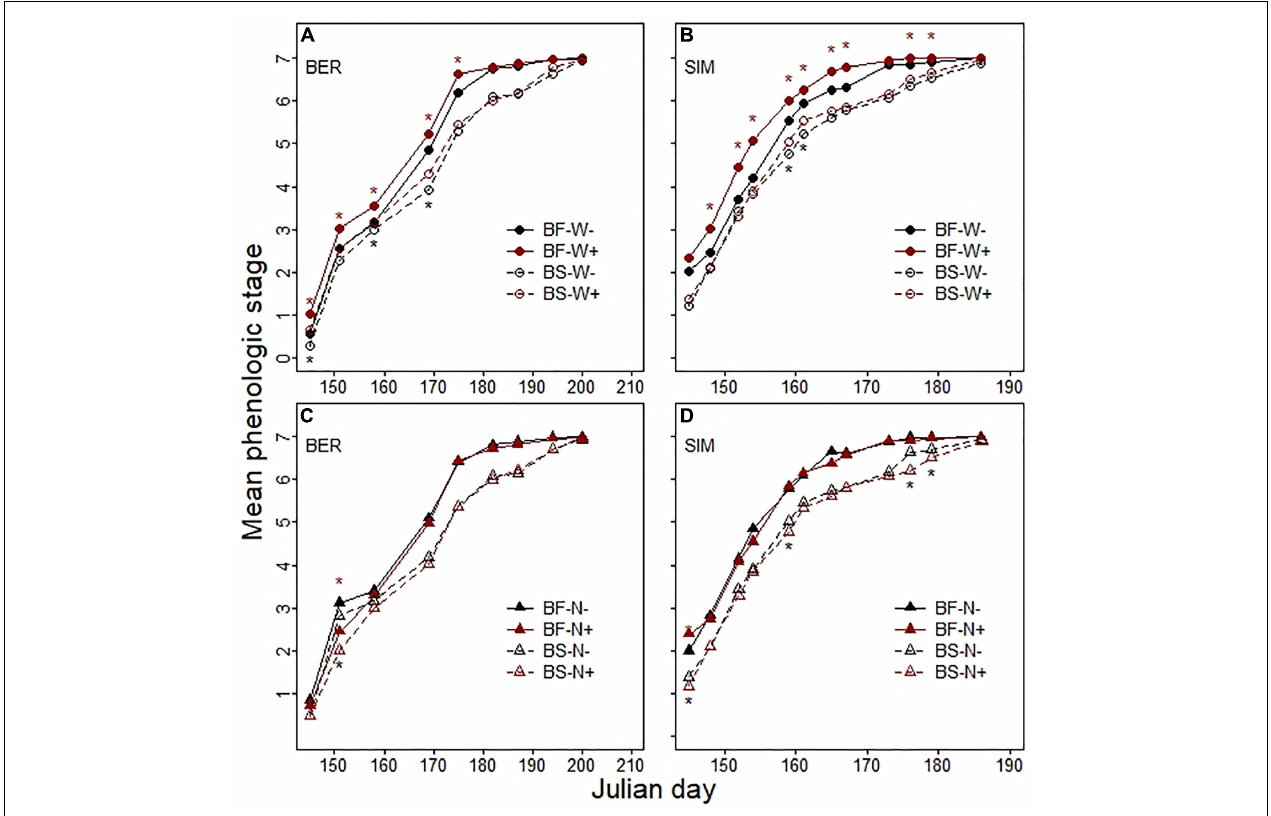
FIGURE 5 | Change in the mean phenologic stage for balsam fir (BF) and black spruce (BS) in (A,B) warmed (W+) and unwarmed (W-) plots and (C,D) in fertilized (N + ) and unfertilized (N-) plots across the 2016 growing season at the BER and SIM sites. * indicate significant differences between treatments for BF (red symbols) and BS (black symbols) (Wilcoxon’s rank-sum test; P <